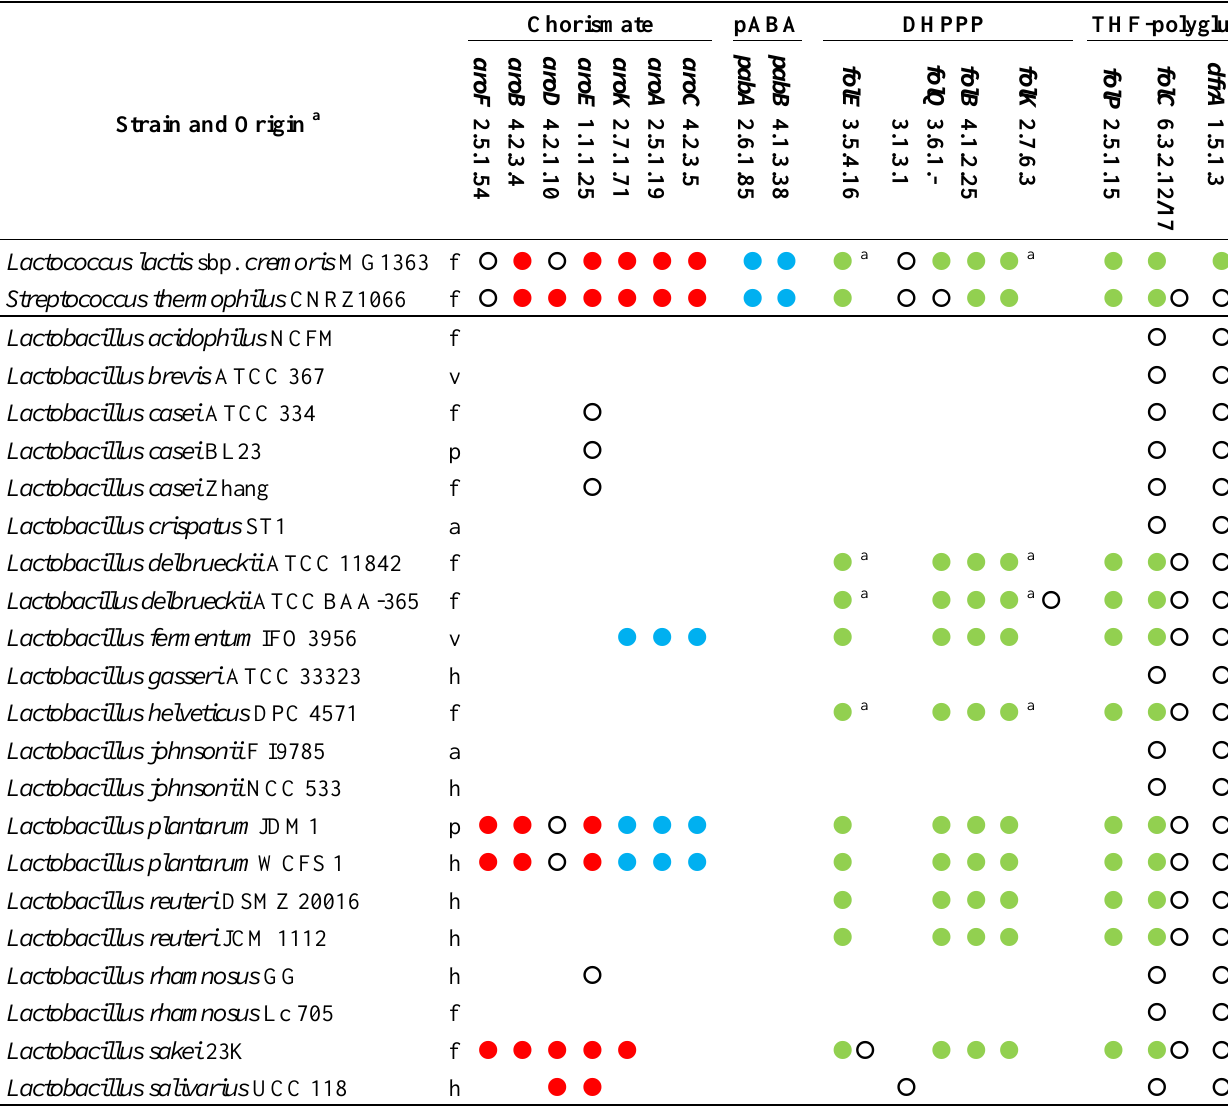
Table 1. Genes and enzymes for the biosynthesis of DHPPP, THF-polyglutamate, chorismate, and pABA predicted from the sequenced genomes of genus Lactobacillus and other lactic acid bacteria [46]. Abbreviations: pABA, para-aminobenzoic